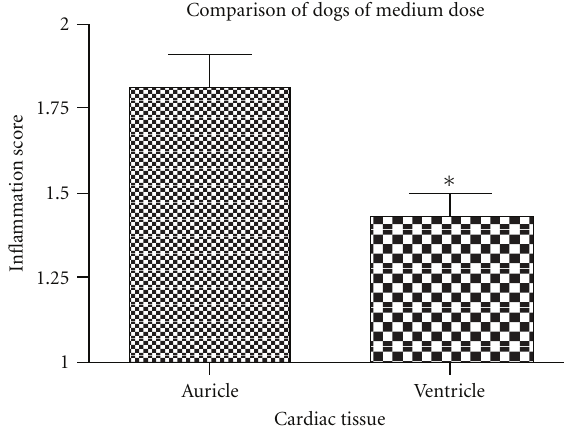
Figure 3: Auricular tissue presents significantly more inflammation than ventricular ( P = 0 . 0027). Mean + SEM is shown.